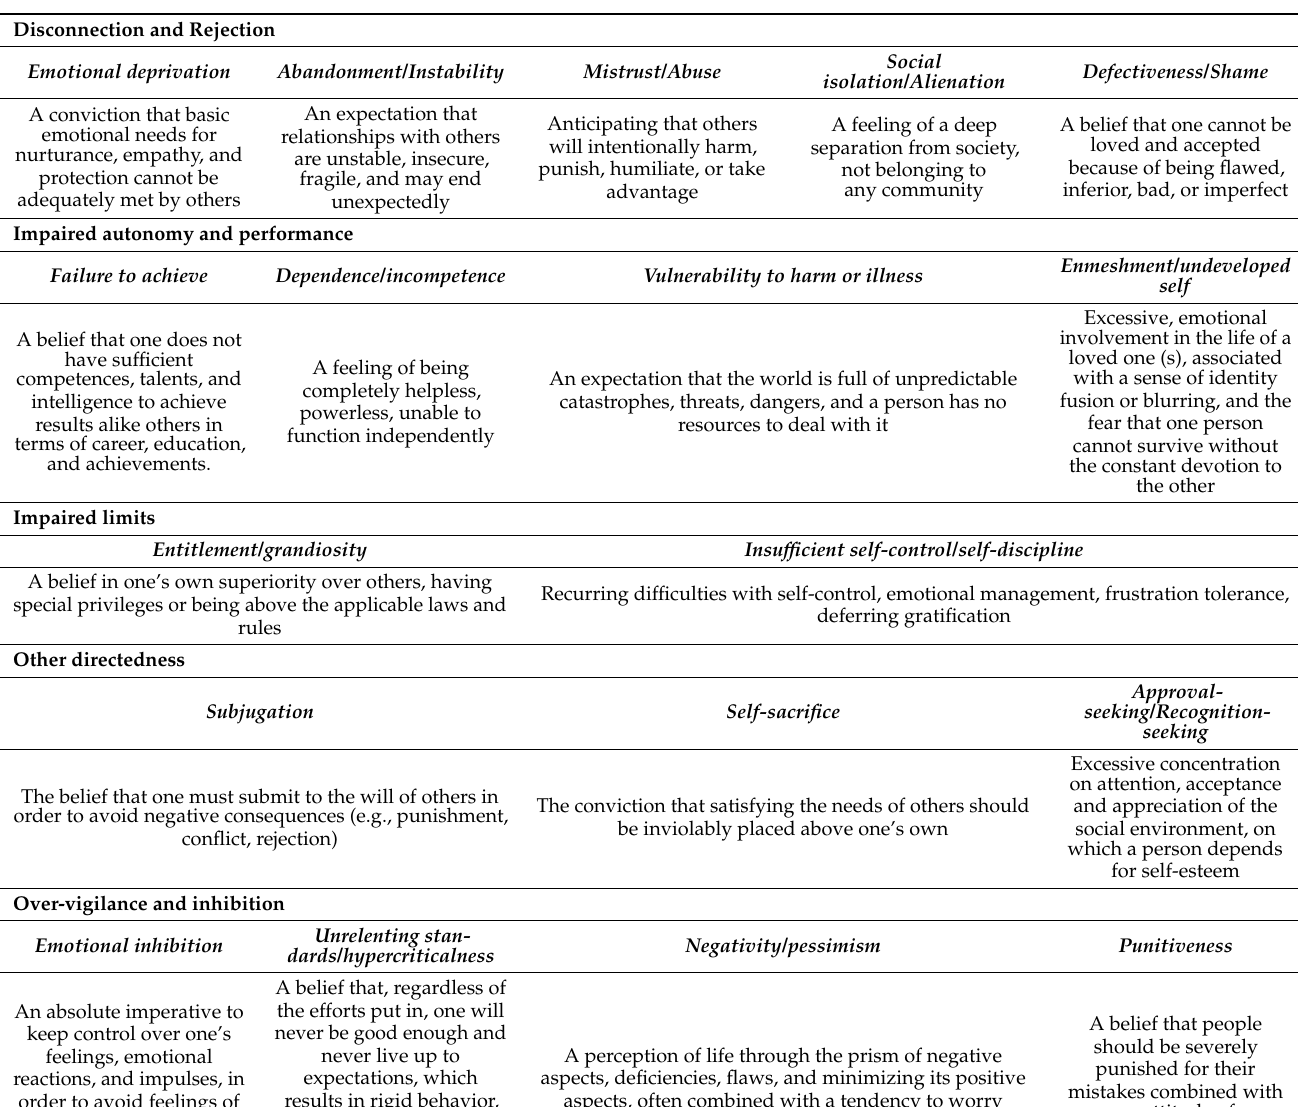
Table 1. Short description of the early maladaptive